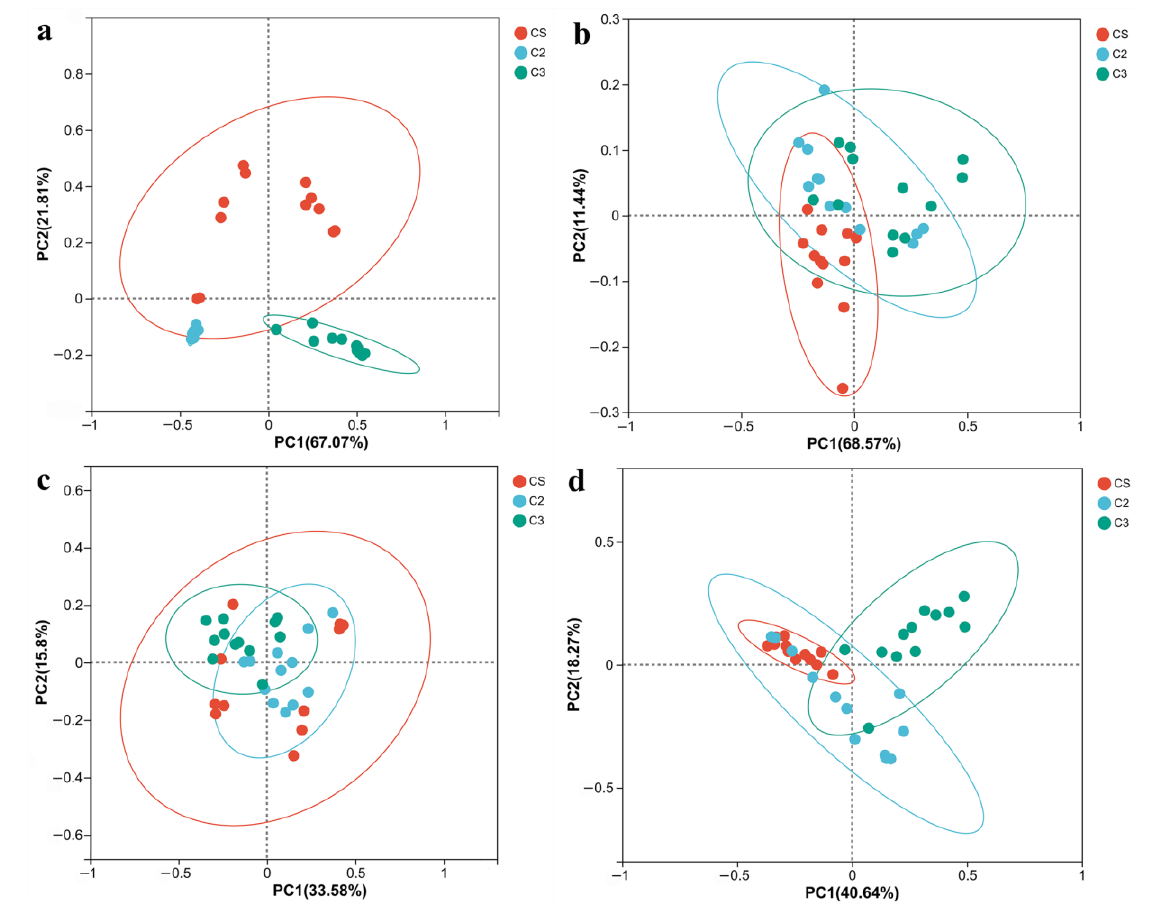
Figure 5. PCoA analysis of the microbial genera in the fermented grains during the sauce-flavor Baijiu manufacturing process. ( a ) bacteria from 0 and 7th d samples. ( b ) bacteria from 21st d and fermented end samples. ( c ) fungi from 0 and 7th d samples. ( d ) fungi from 21st d and fermented end